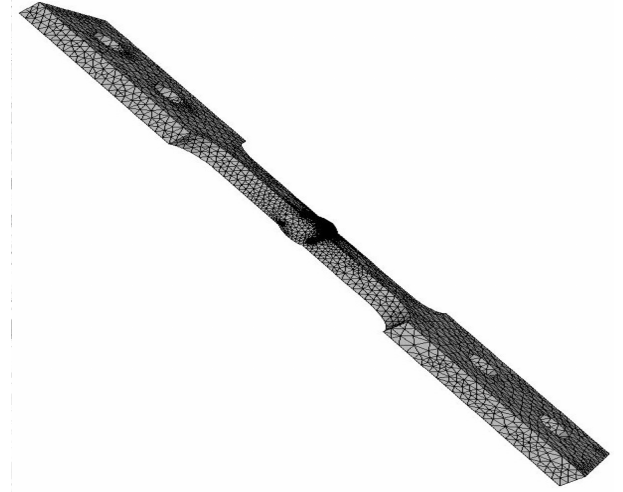
Figure 4. Detail of the mesh generation for the weld joint model.